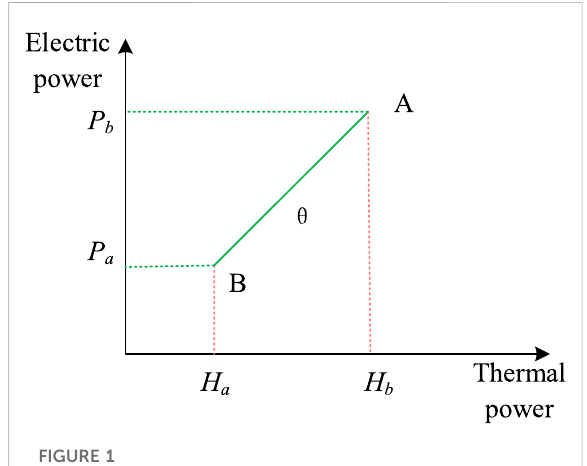
FIGURE 1 Electrothermal characteristics of the back pressure